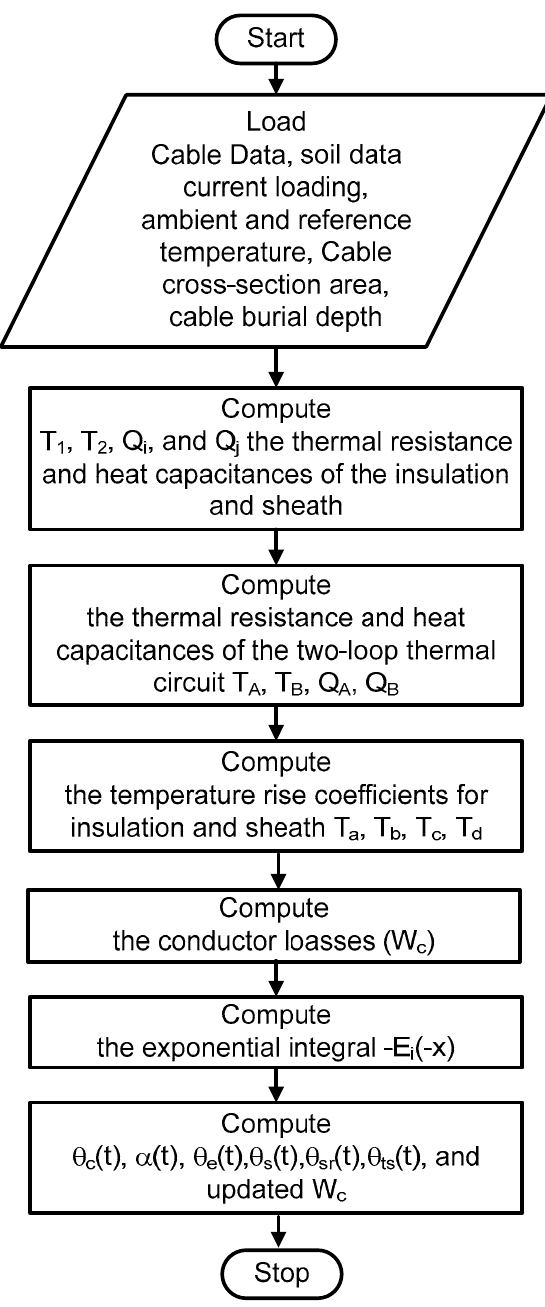
Figure 7. Temperature distribution through the cable elements. Table 1. input data for cable dimension, soil properties, and temperatures.